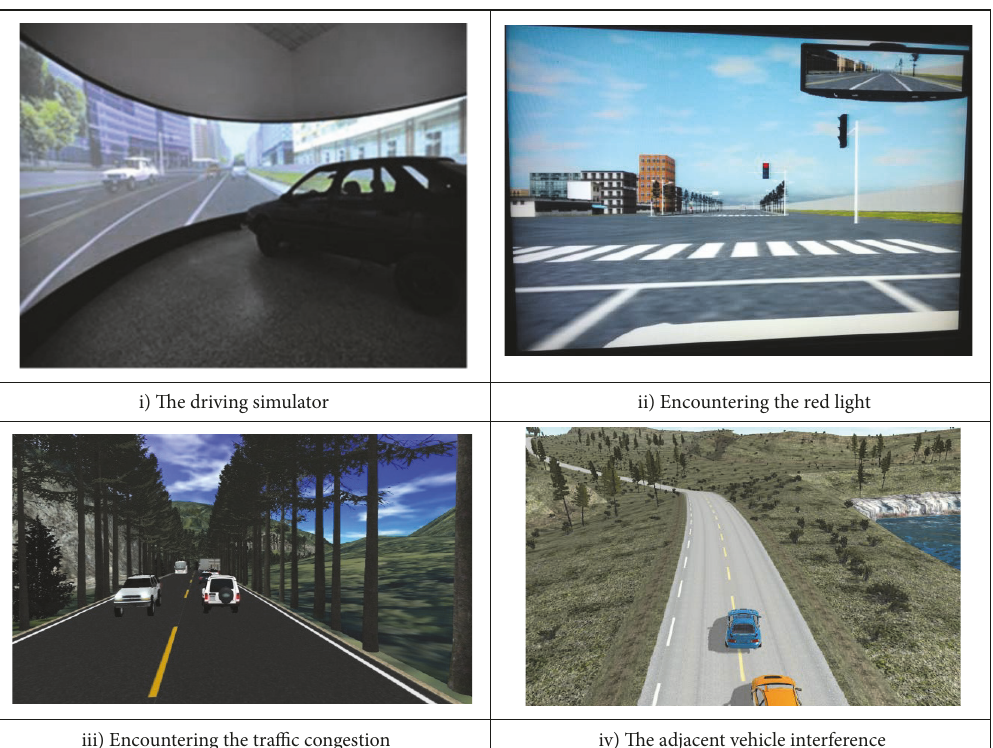
Figure 4: The induction scenarios of driving